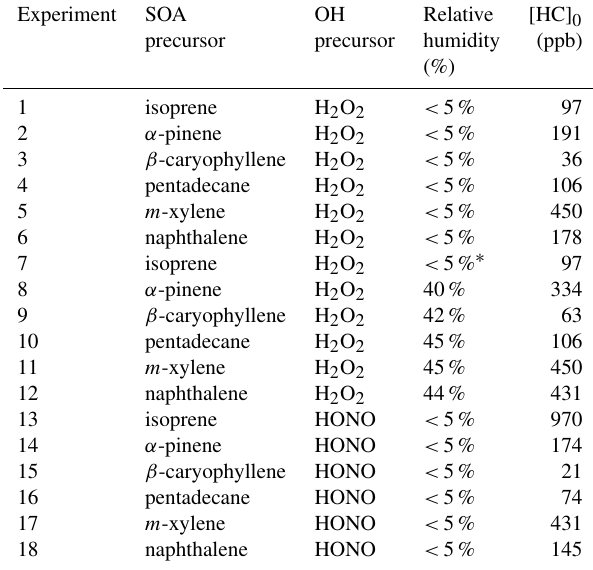
Table 1. Experimental